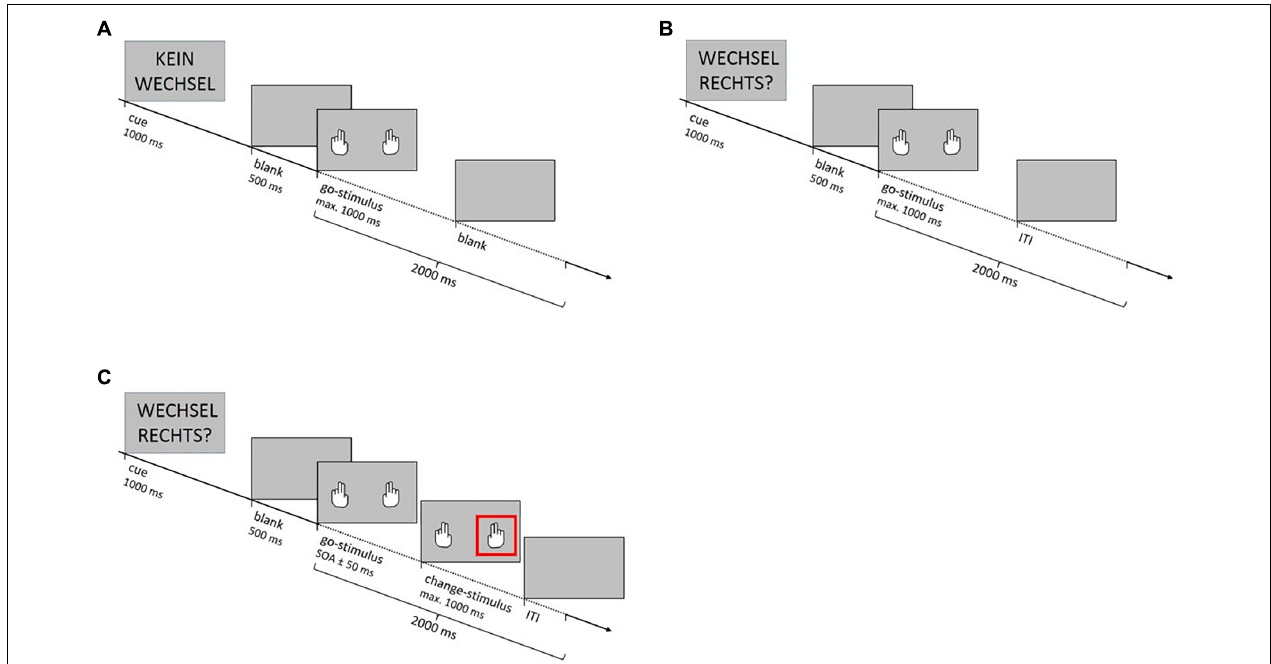
FIGURE 1 | (A) On non-critical go trials the cue “No change” (“Kein Wechsel” in German) signaled that a go response was required for certain. (B) Cues on critical go trials signaled that either a go or a change reaction was required. In the foreknowledge condition cues were “Change right?” and “Change left?” (“Wechsel rechts?” or “Wechsel links?” in German) and indicated which hand had to execute the alternative response in case of a change trial. In the no-foreknowledge condition the cue “Change xxx?” (“Wechsel xxx?” in German) was uninformative. (C) . On change trials the go stimulus was unpredictably followed by the change signal after a variable delay (stimulus onset asynchrony, SOA). The change signal was represented by a red square framing either the right or the left hand. It indicated that participants had to refrain from executing the go reaction with the respective hand and instead press the key assigned to the middle finger (change reaction). When participants gave their response or after 1 s in which no response occurred, the trial terminated with a blank screen